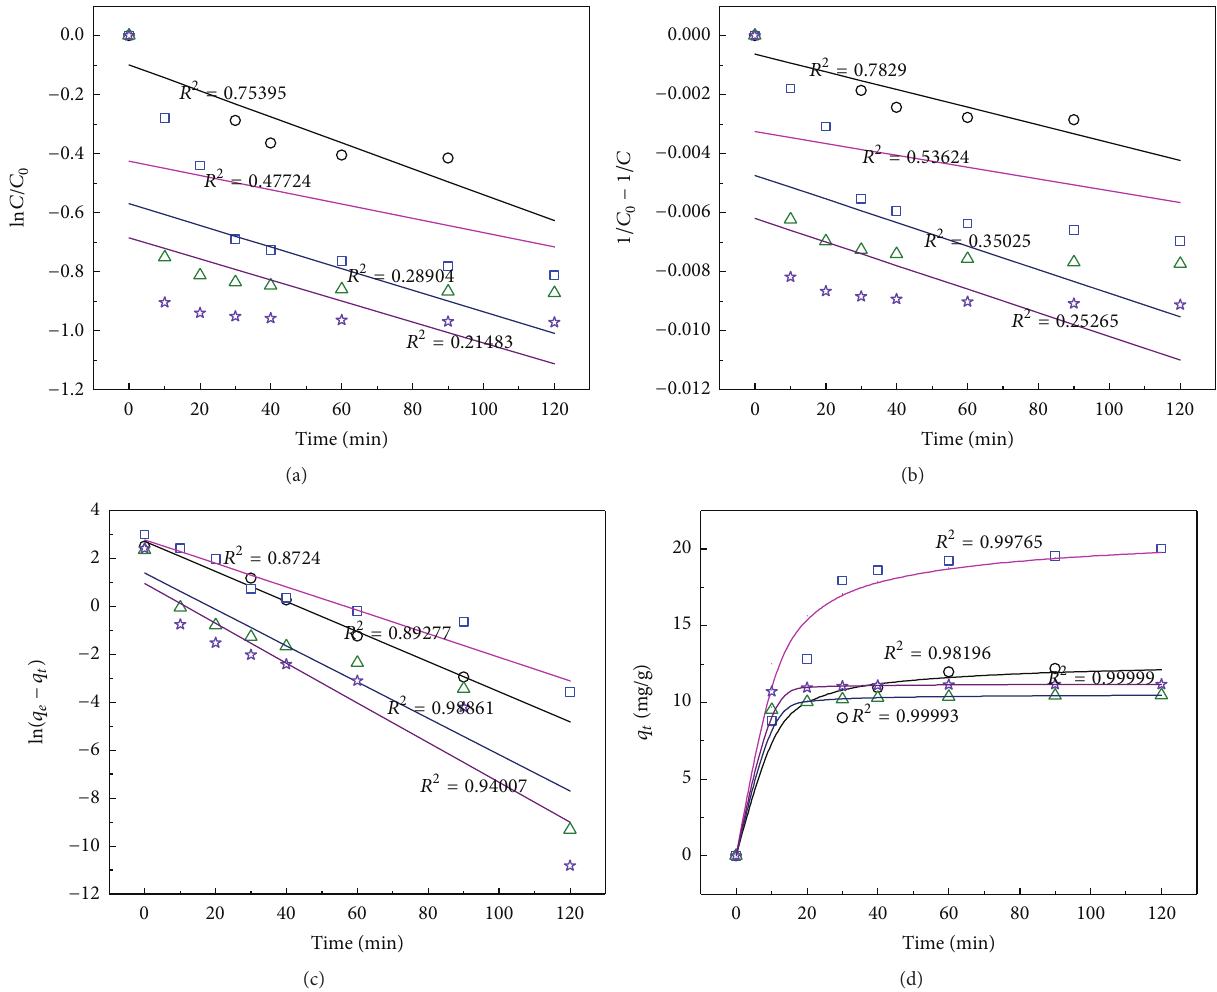
Figure 2: Four kinetic models for the adsorption of Cu 2+ by OCB, CB, organic bentonite, and bentonite. The solid line is the fit to the four